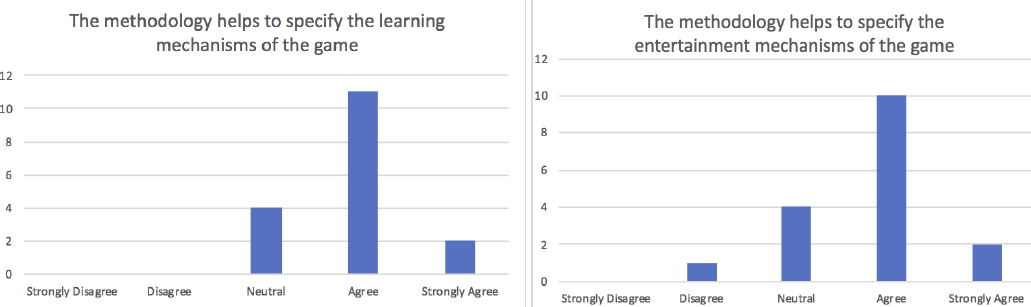
Figure 4. Answer graph about methodology: ( left ) Does it help to specify game learning mechanisms? ( right ) Does it help to specify game entertainment